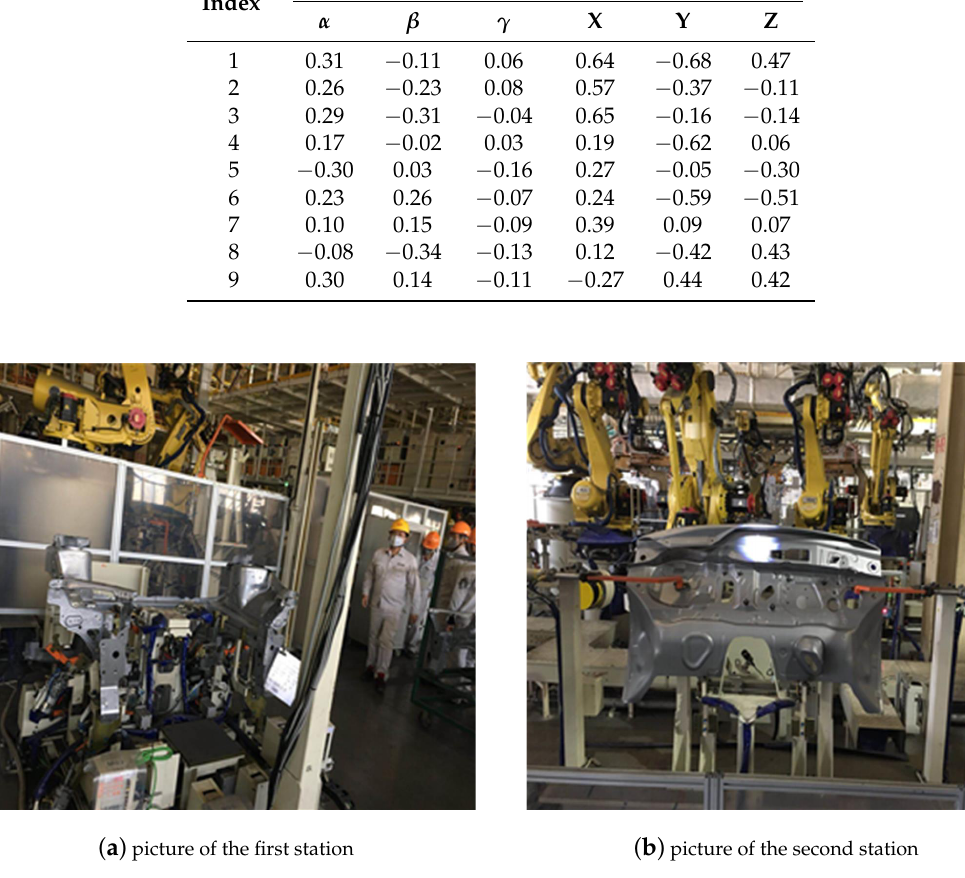
Figure 12. Two different stations in the automobile production line with intelligent grasping system: ( a ) the first station; ( b ) the second